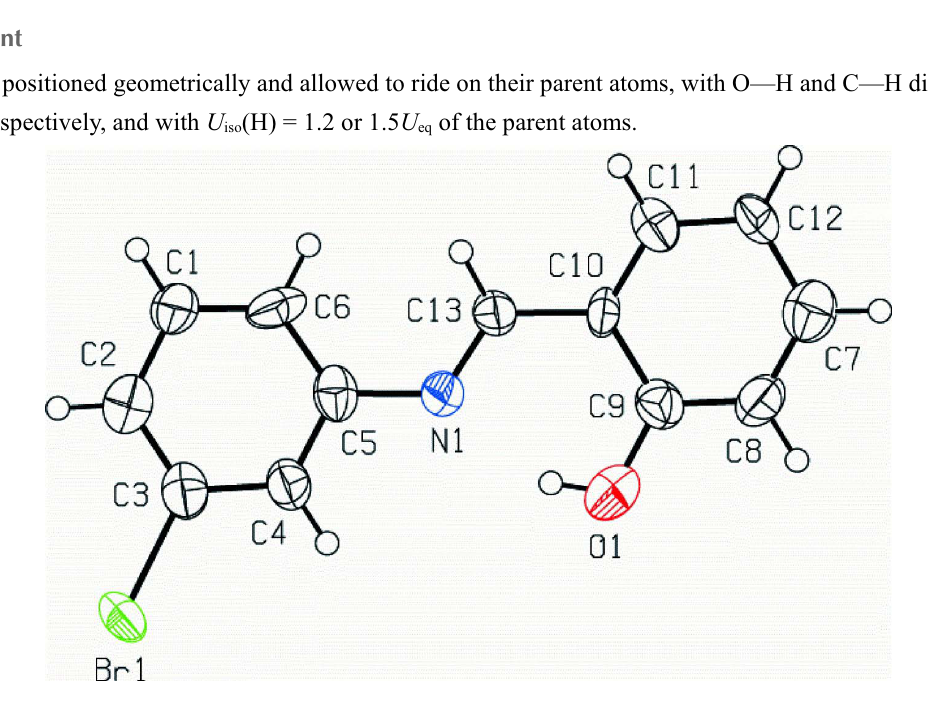
The molecular structure of the title compound with the atom-labeling scheme. Displacement ellipsoids are drawn at the 50% probability